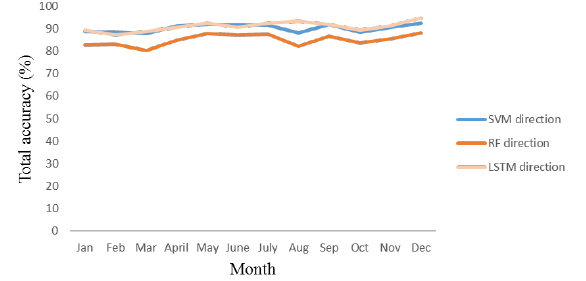
Figure 5: Total accuracy for different months for Netherlands (in direction